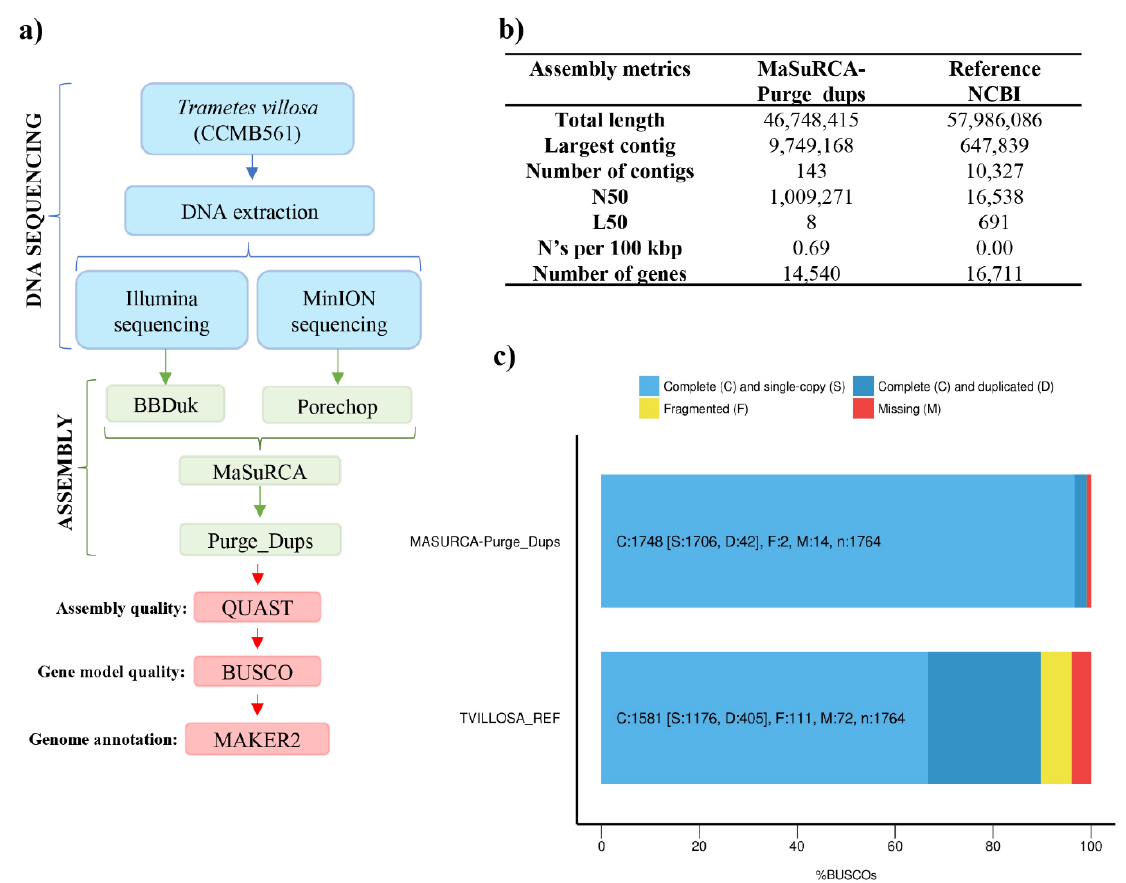
Figure 1. Overview of the newly assembled genome of Trametes villosa CCMB561. ( a ) Assembly workflow proposed as the best approach for genome assembly. ( b ) Summary evaluation of the genome assembled through MaSuRCa-Purge_Dups workflow and the reference genome of Trametes villosa deposited in the NCBI database (GCA_002964805.1). ( c ) BUSCO completeness assessment of the new genome and the reference of Trametes villosa previously deposited in the NCBI (GCA_002964805.1). Table 3. Completeness assessment of Trametes villosa CCMB561 assemblies using BUSCO soft- ware.